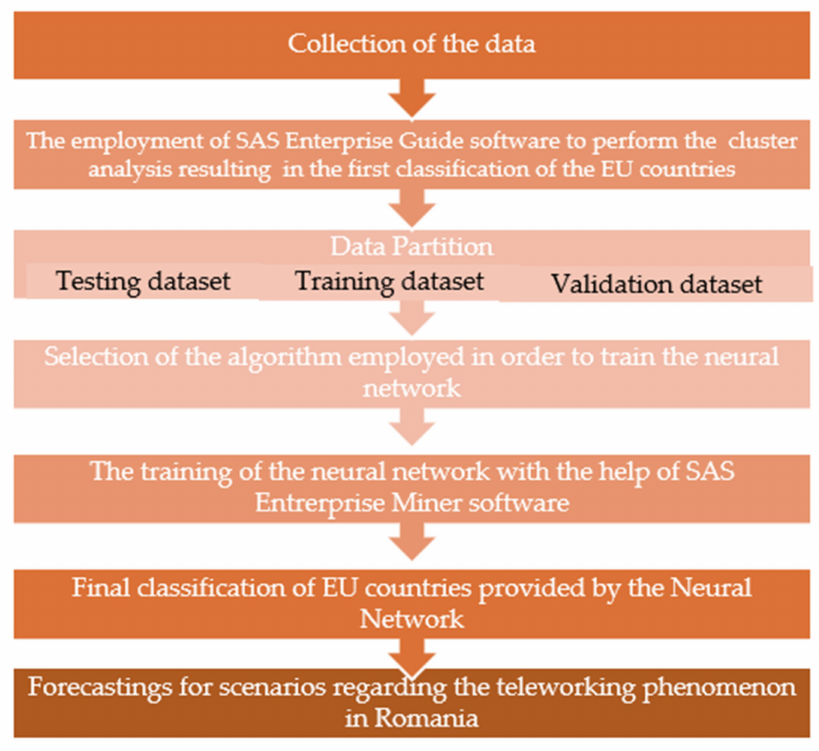
Figure 4. The design of the research on teleworking in EU countries and